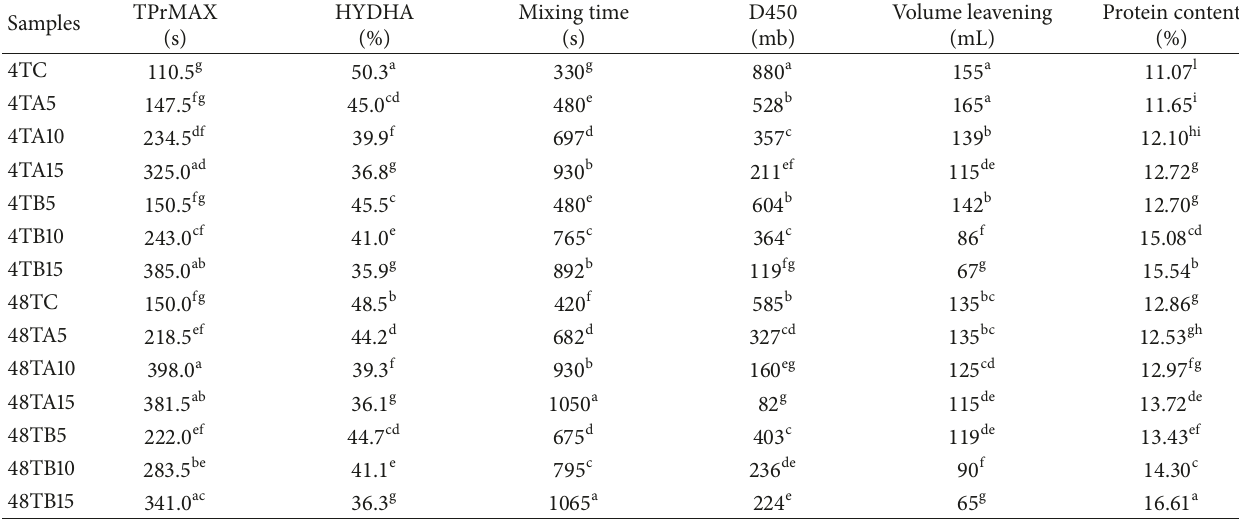
Table 3: Properties of dough samples. TPrMax, HYDHA, mixing time, and D450 are Consistograph parameters.